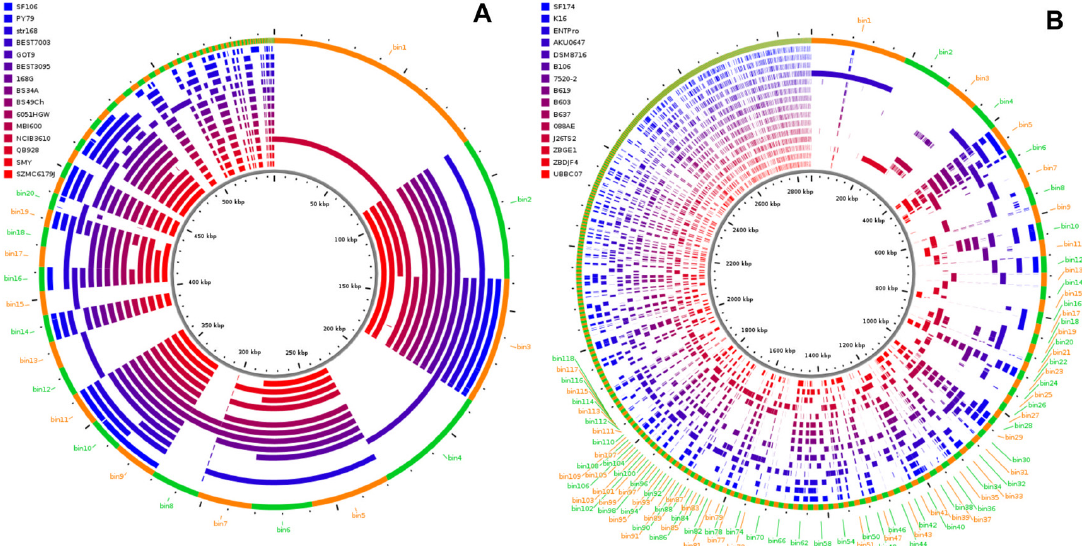
Figure 6. Distribution of the accessory genes of the 15 B. subtilis ( A ) and 15 A. clausii ( B ) genomes identified by the pangenomic analysis. The outer ring shows ClustAGE bins at least 200 bp in size ordered clockwise from largest to smallest with alternating orange and green colors to indicate bin borders. The ruler in the center of the figure indicates the cumulative size of the accessory genome bin representatives in kilobases. Figure generated using ClustAGE Plot utility available at http://vfsmspineagent.fsm.northwestern.edu/cgi-bin/clustage_plot.cgi, accessed on 1 April 2022, (version 0.8).